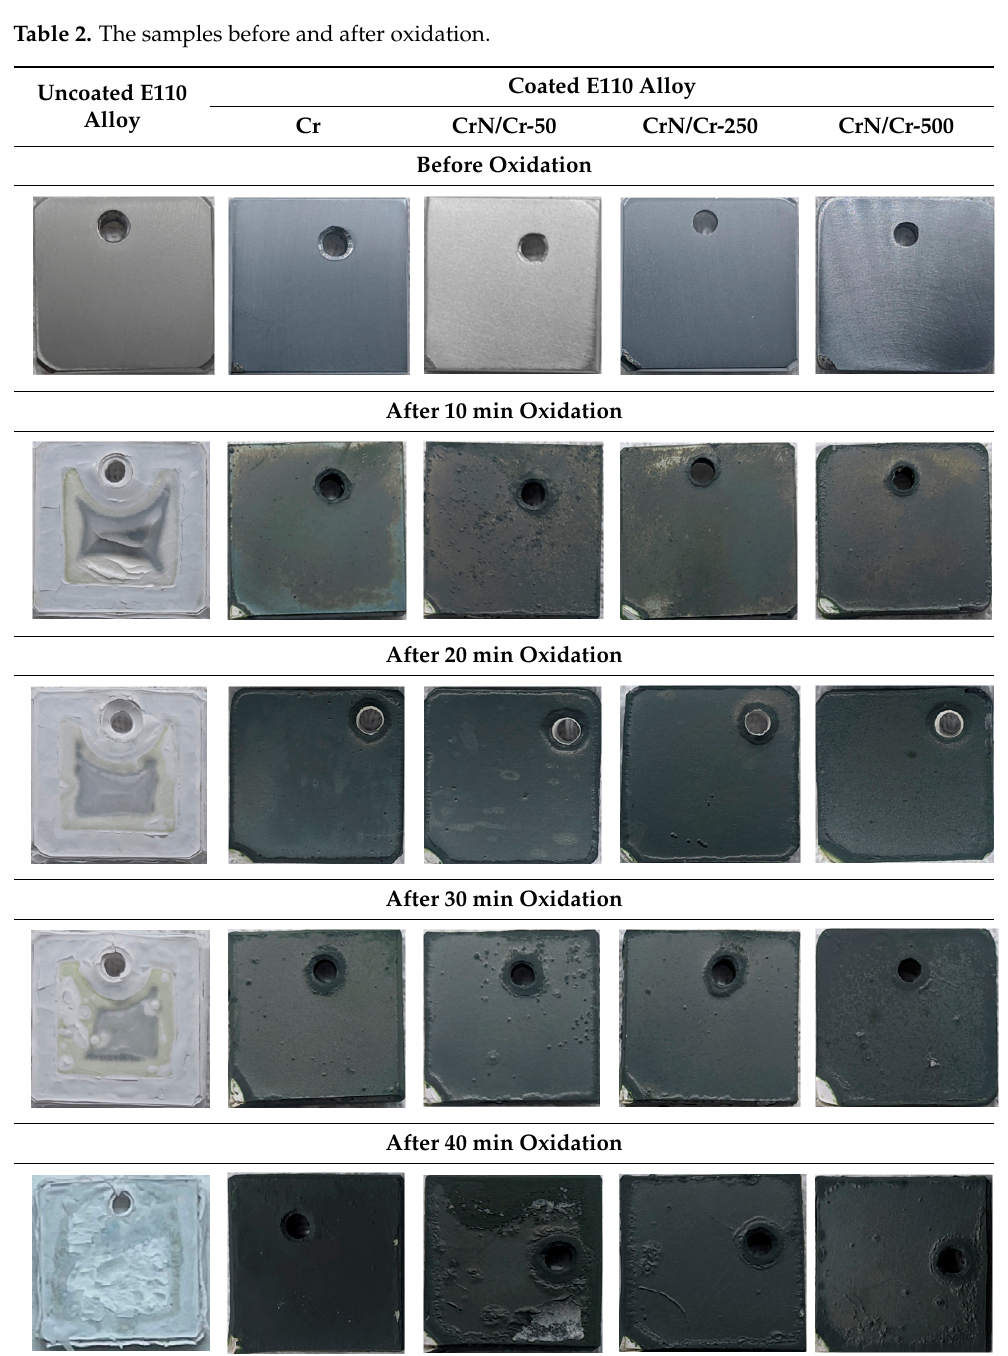
Table 2. The samples before and after oxidation.